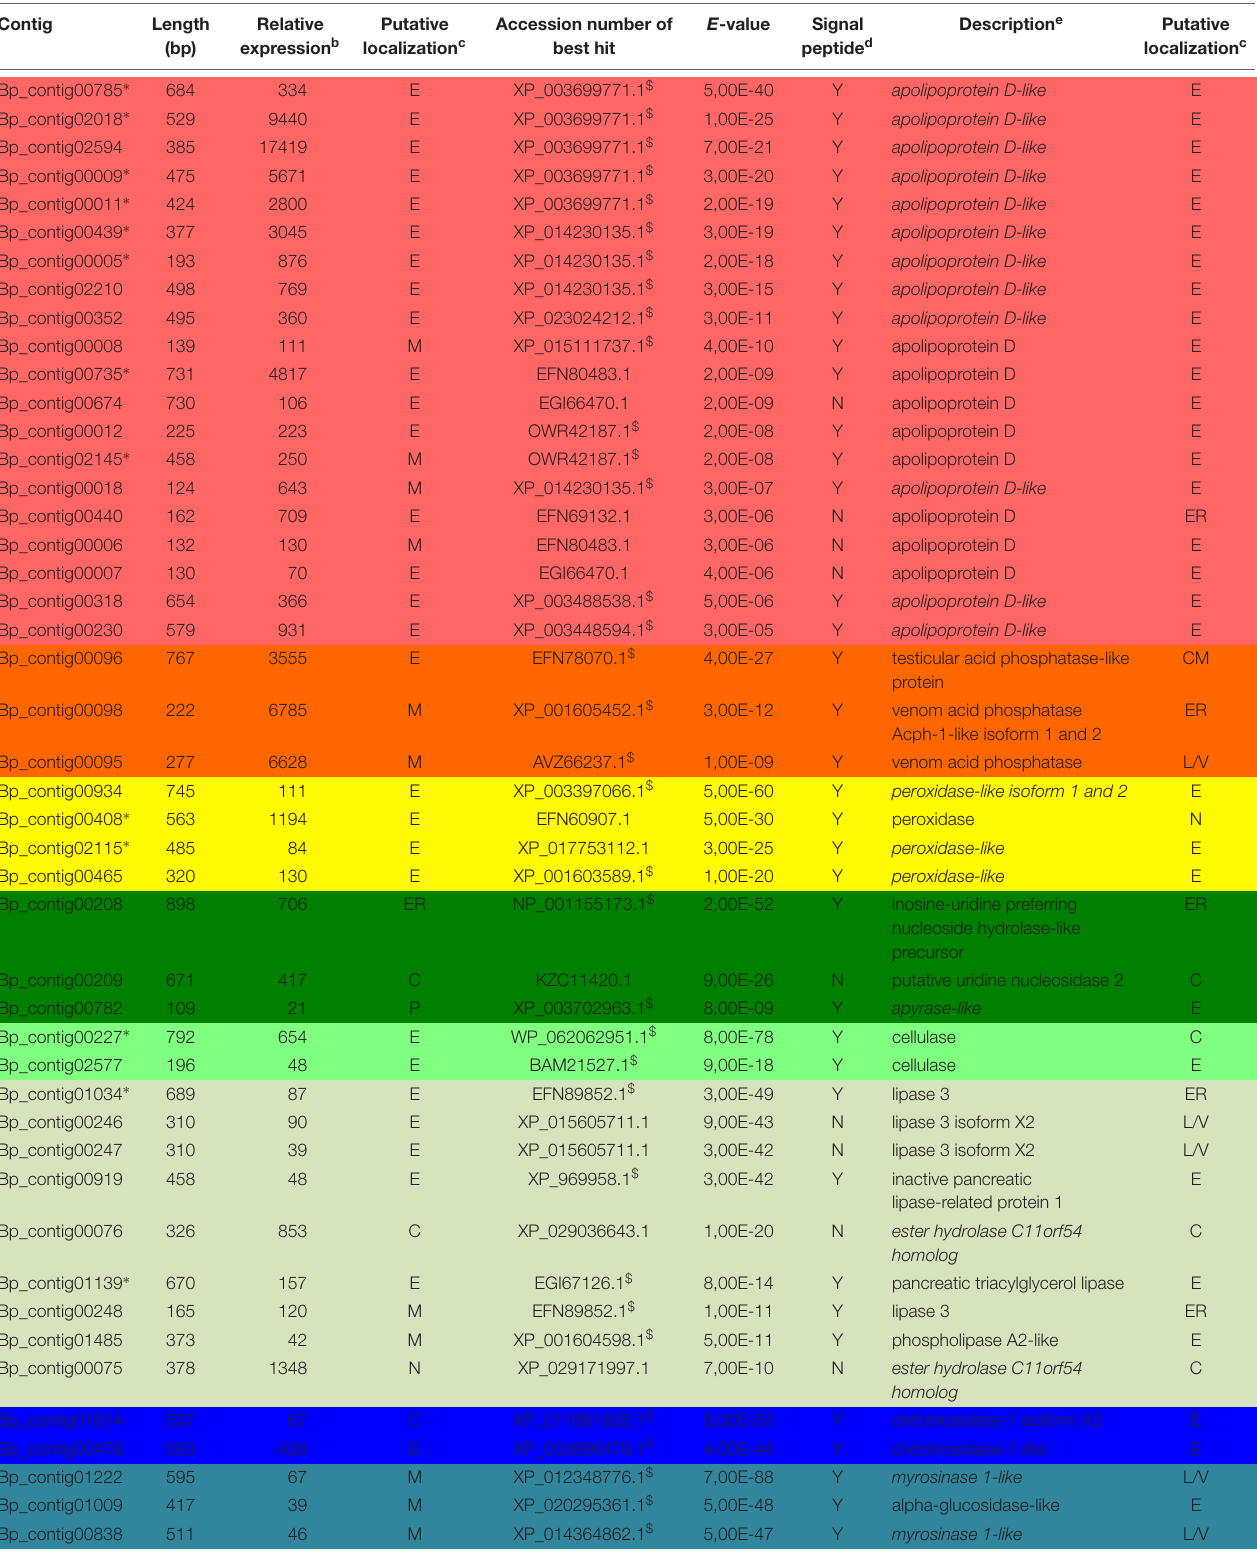
TABLE 2 | Biorhiza pallida contigs differentially expressed in venom glands a . Contig Length